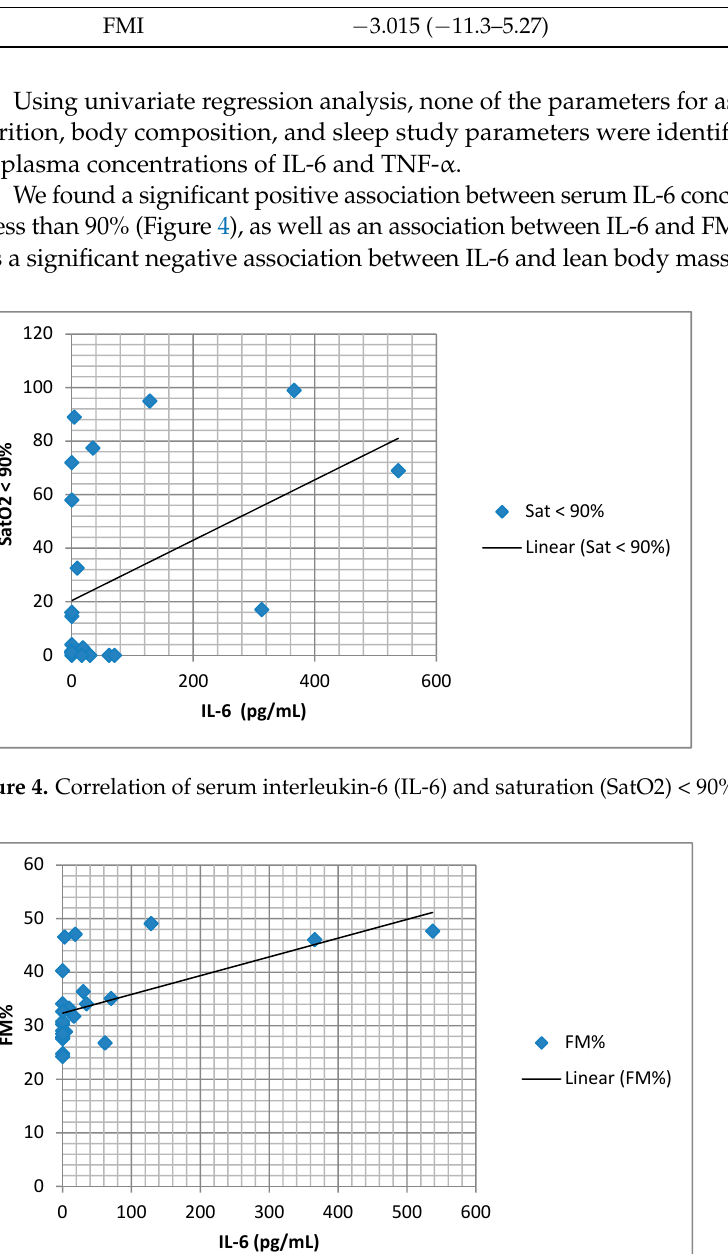
Figure 5. Correlation of serum IL-6 and FM% (r = 0.579, p = 0.003) .